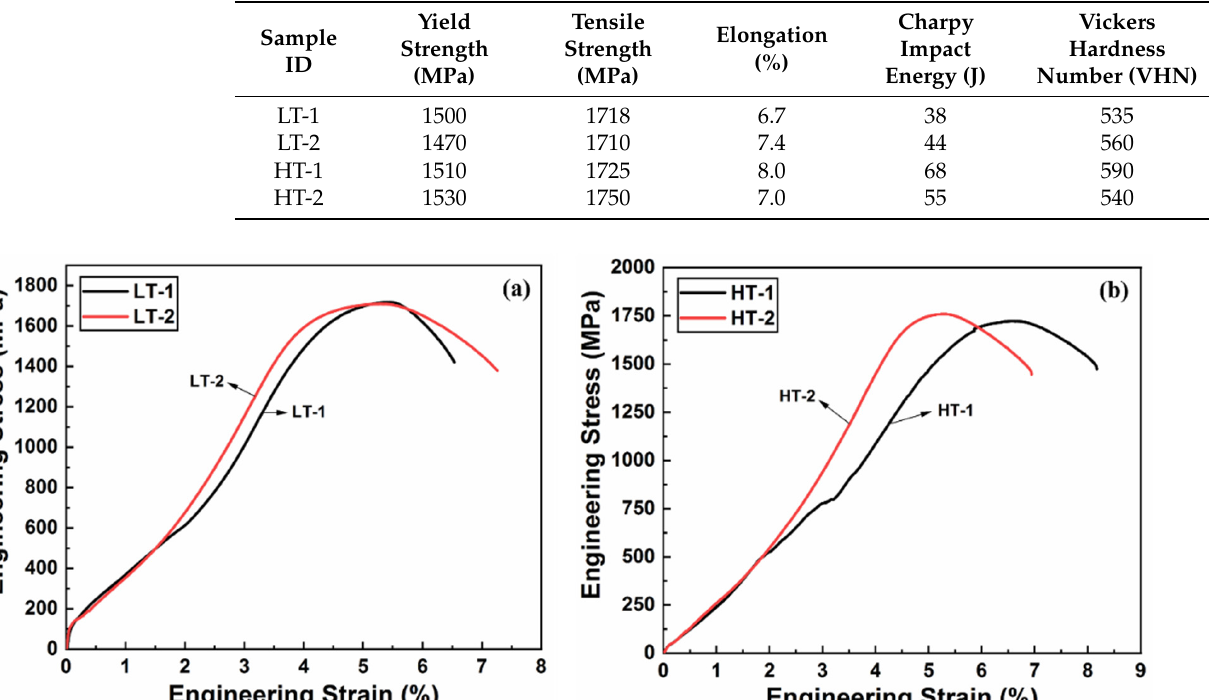
Figure 6. Engineering stress and strain plots of ballistic steel samples: ( a ) LT-1/LT-2 and ( b ) HT- 1/HT-2.